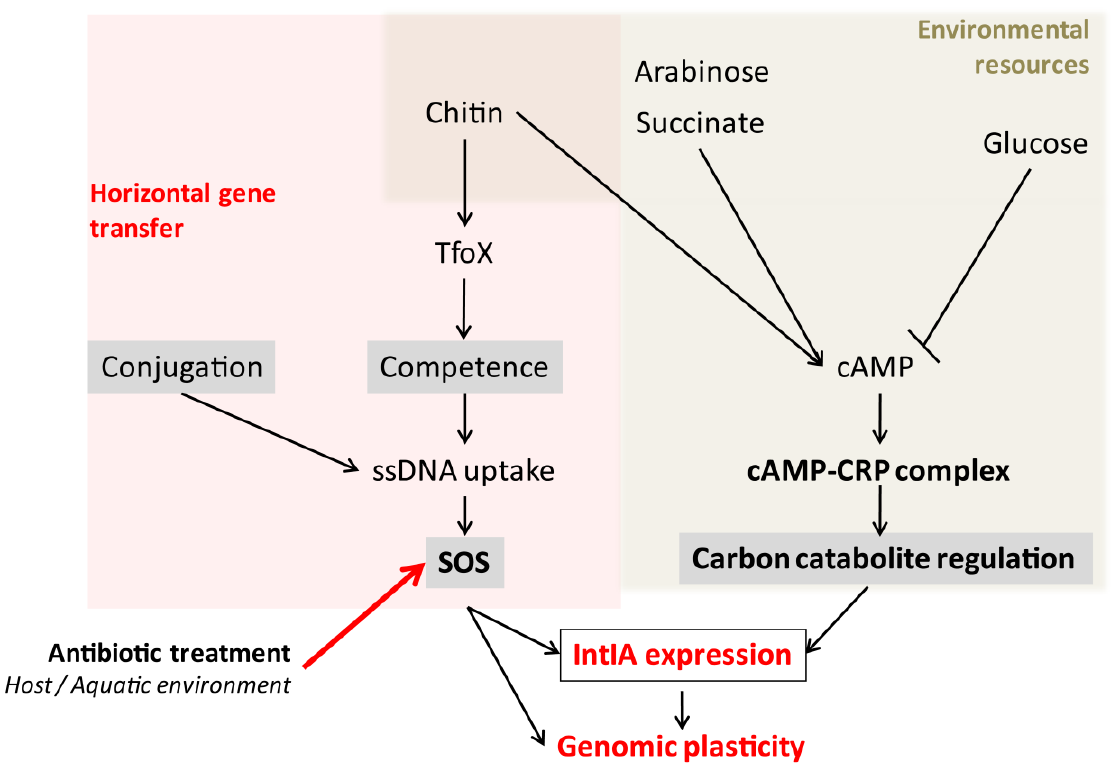
Figure 1. Model of intIA regulation and its implications for genome plasticity. Grey boxes represent mechanisms involved in IntIA regulation. Horizontal gene transfer (conjugation, transformation) induces SOS through ssDNA uptake by recipient cells, which in turn triggers intIA transcription. Carbon sources present in the environment also regulate IntIA expression through carbon catabolite control (adapted from [31], Copyright© American Society for